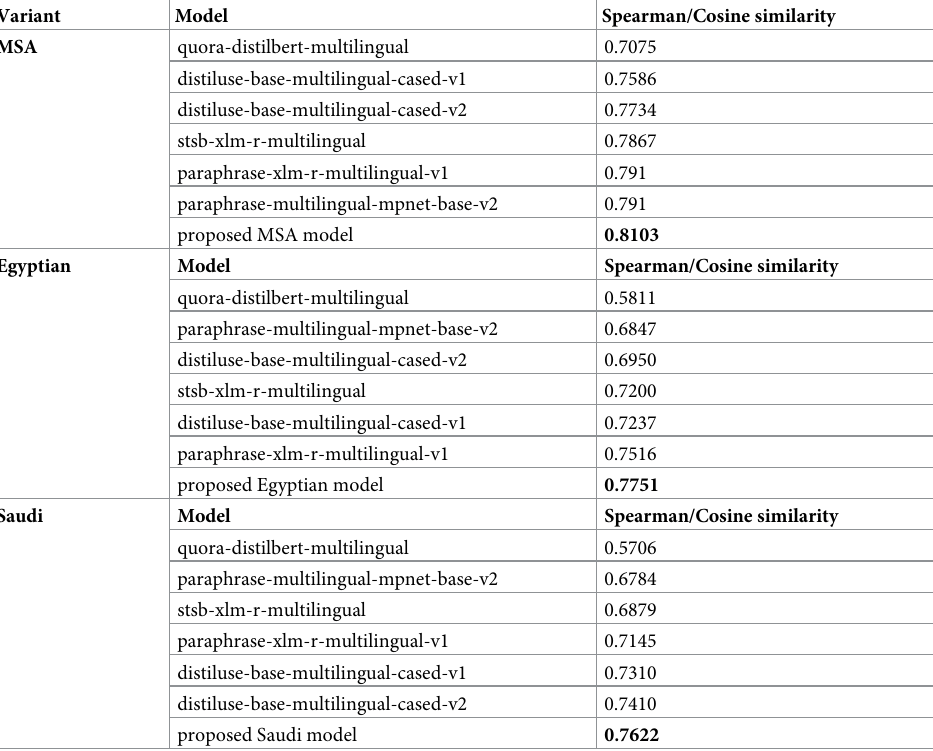
Table 7. Comparisons between the proposed models and current state-of-the-art Arabic STS models based on Spearman rank correlation between the cosine similarity of sentence representations and the reference labels of the testing dataset in